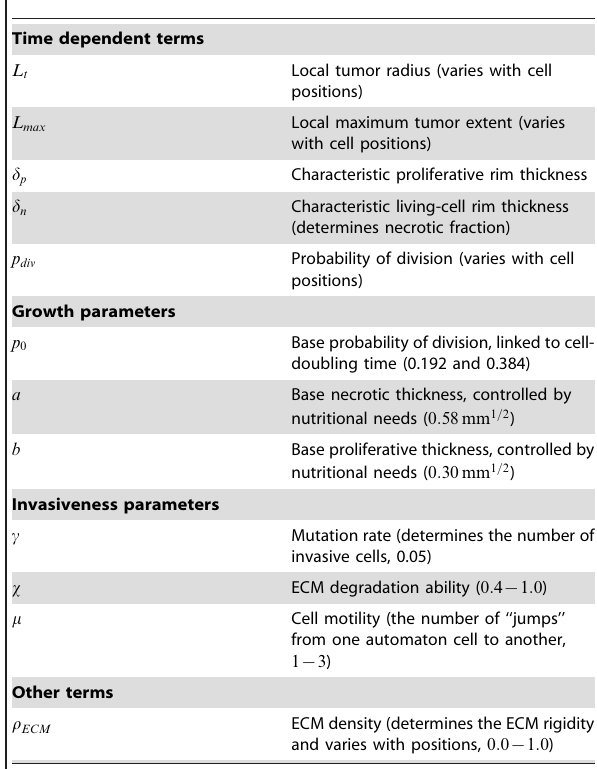
Table 1. Parameters and terms in the CA